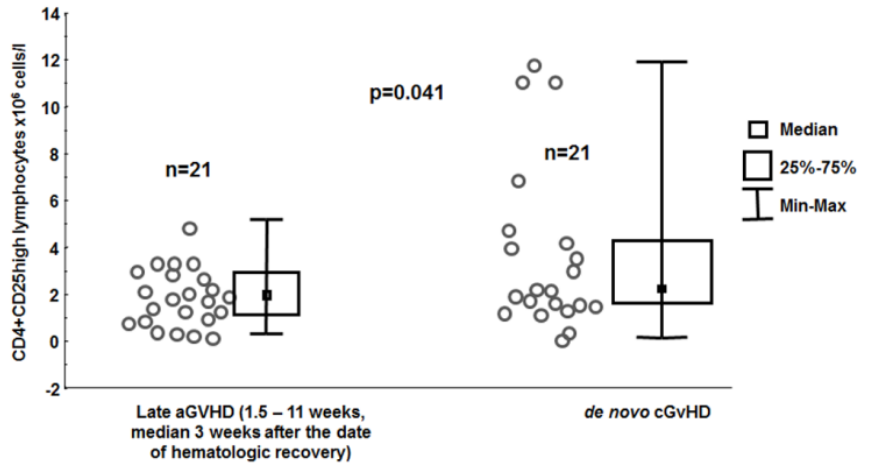
Figure 3. Numbers of CD4+CD25high lymphocytes in the blood determined at the beginning of hematologic recovery in the groups of patients with late aGvHD and those with de novo cGvHD.